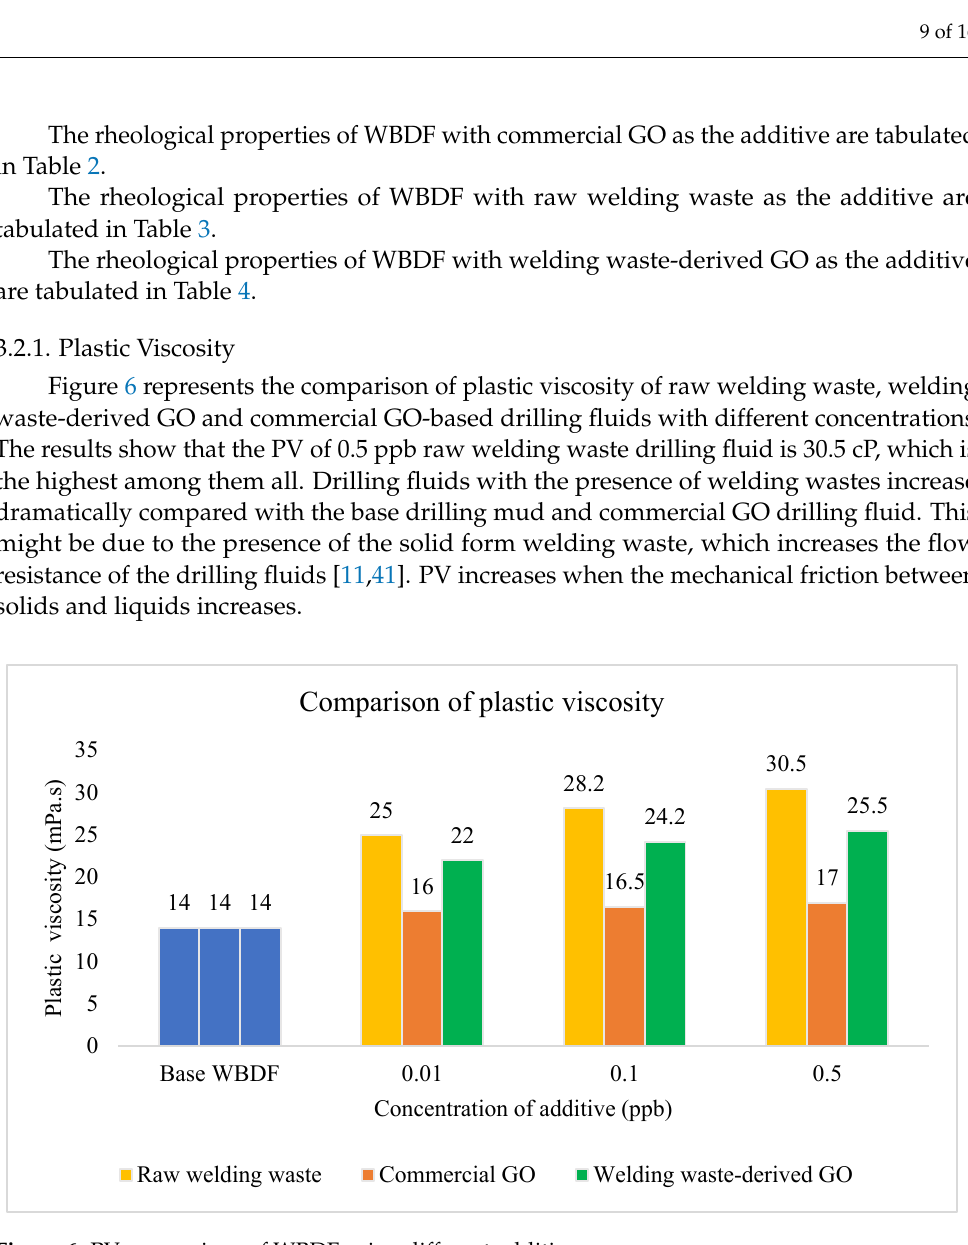
are tabulated in Table 4. Table 4. Rheological properties of welding waste-derived GO.